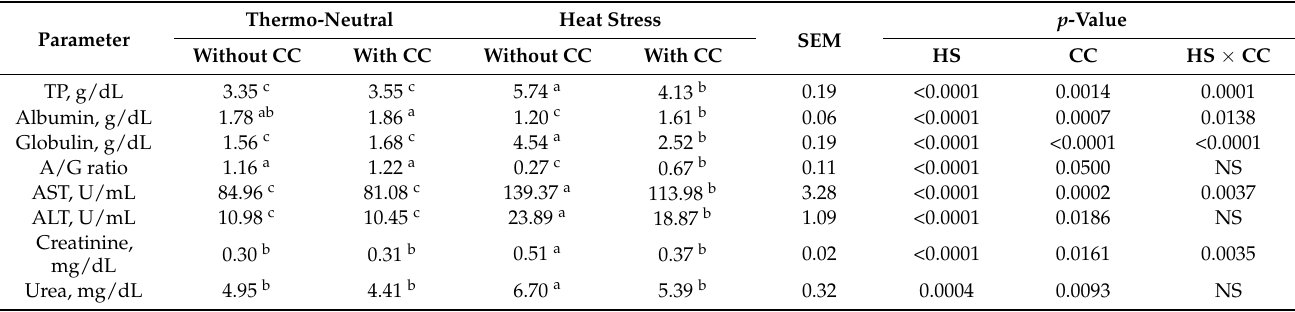
Table 5. Blood biochemical parameters of broilers reared under thermo-neutral (control) or cyclic heat-stress (HS) condition and with or without Citrullus colocynthis (CC) seeds